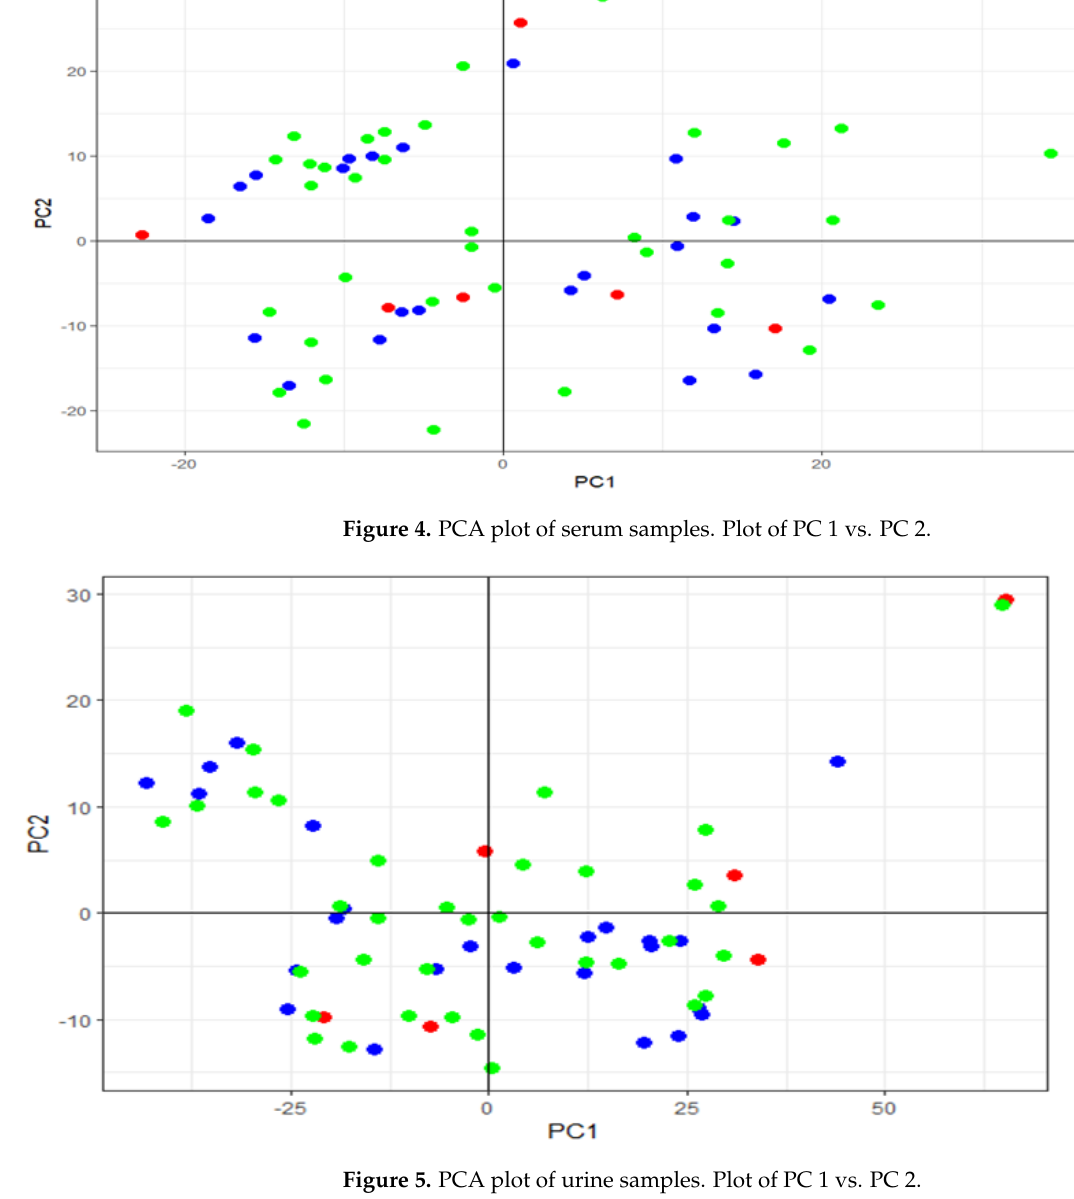
Figure 5. PCA plot of urine samples. Plot of PC 1 vs. PC